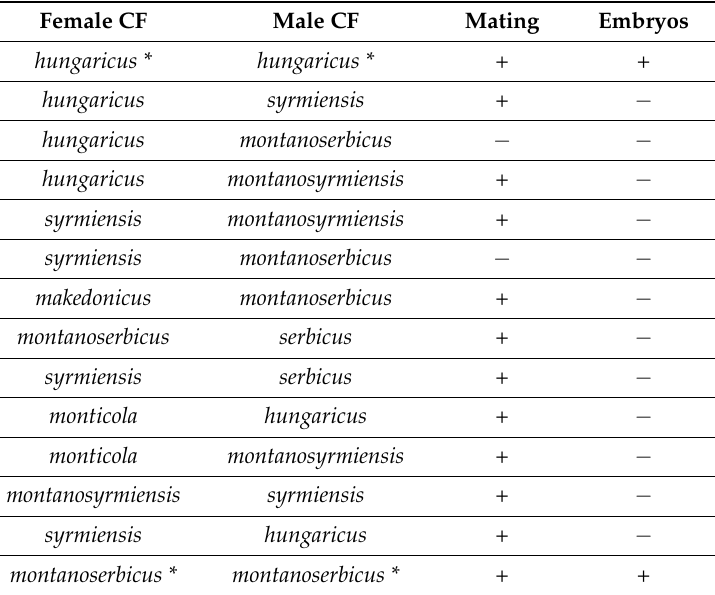
Table 2. Experimental crossbreeding results, from